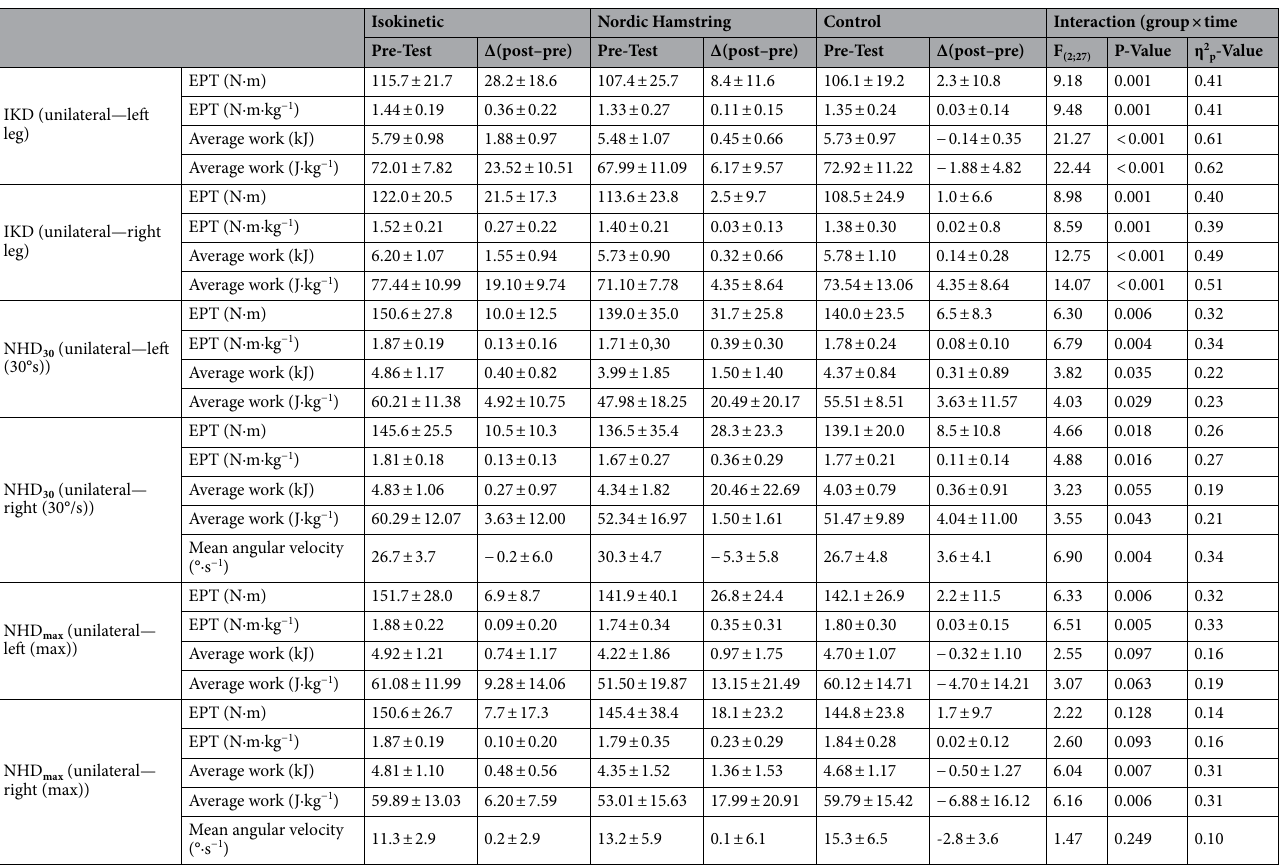
Table 2. Eccentric peak torque and work obtained during the isokinetic and Nordic hamstring exercise tests. Values are express as mean SD; IKD, isokinetic device; NHD30, Nordic hamstring test at a lean